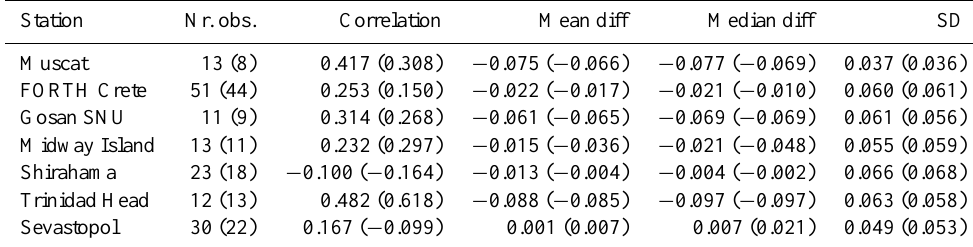
Table 5. The statistics of the real refractive index comparison (at 670nm) at different AERONET stations for the goodness-of-fit + filtering and, between parentheses, the loose cloud mask filtering.